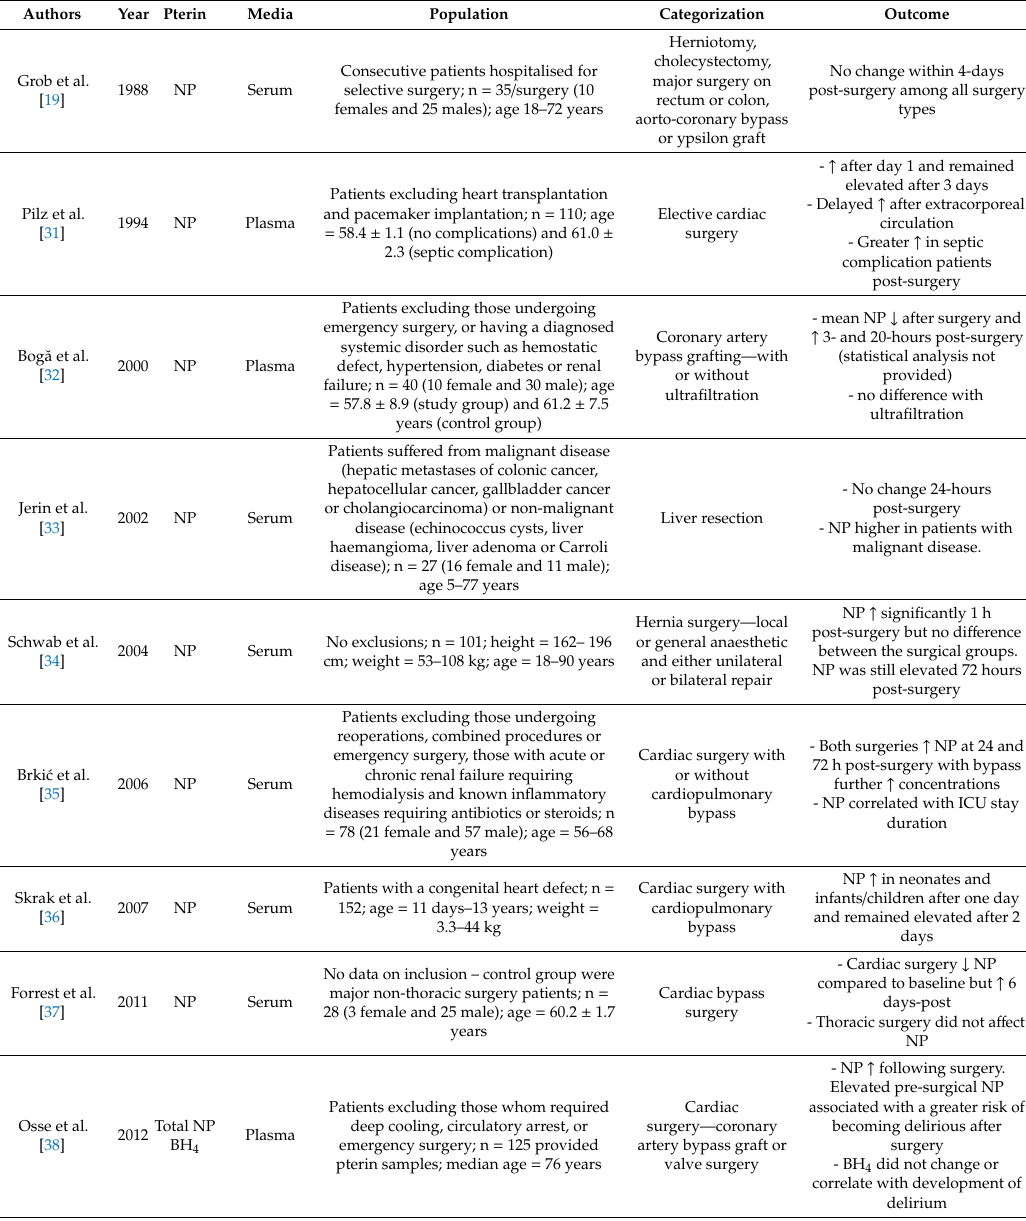
Table 2. Studies measuring pterins following